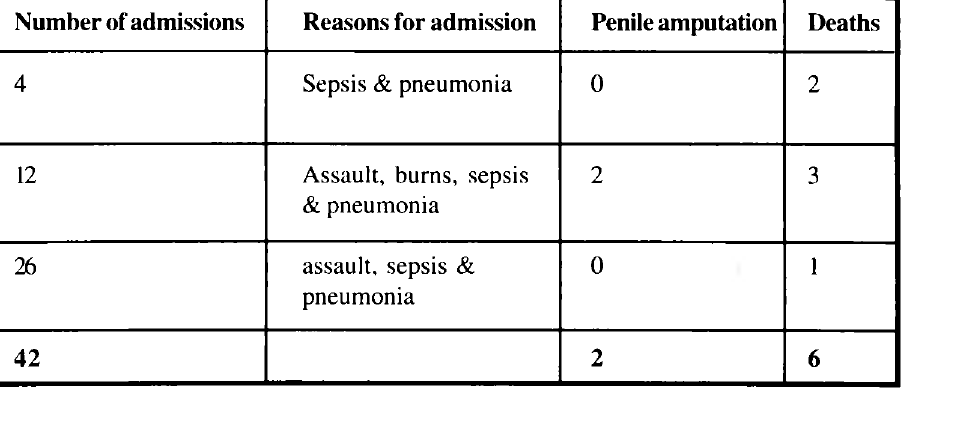
Table 2: Circumcision statistical report, Flagstaff Health District: June - July 2000 Magisterial